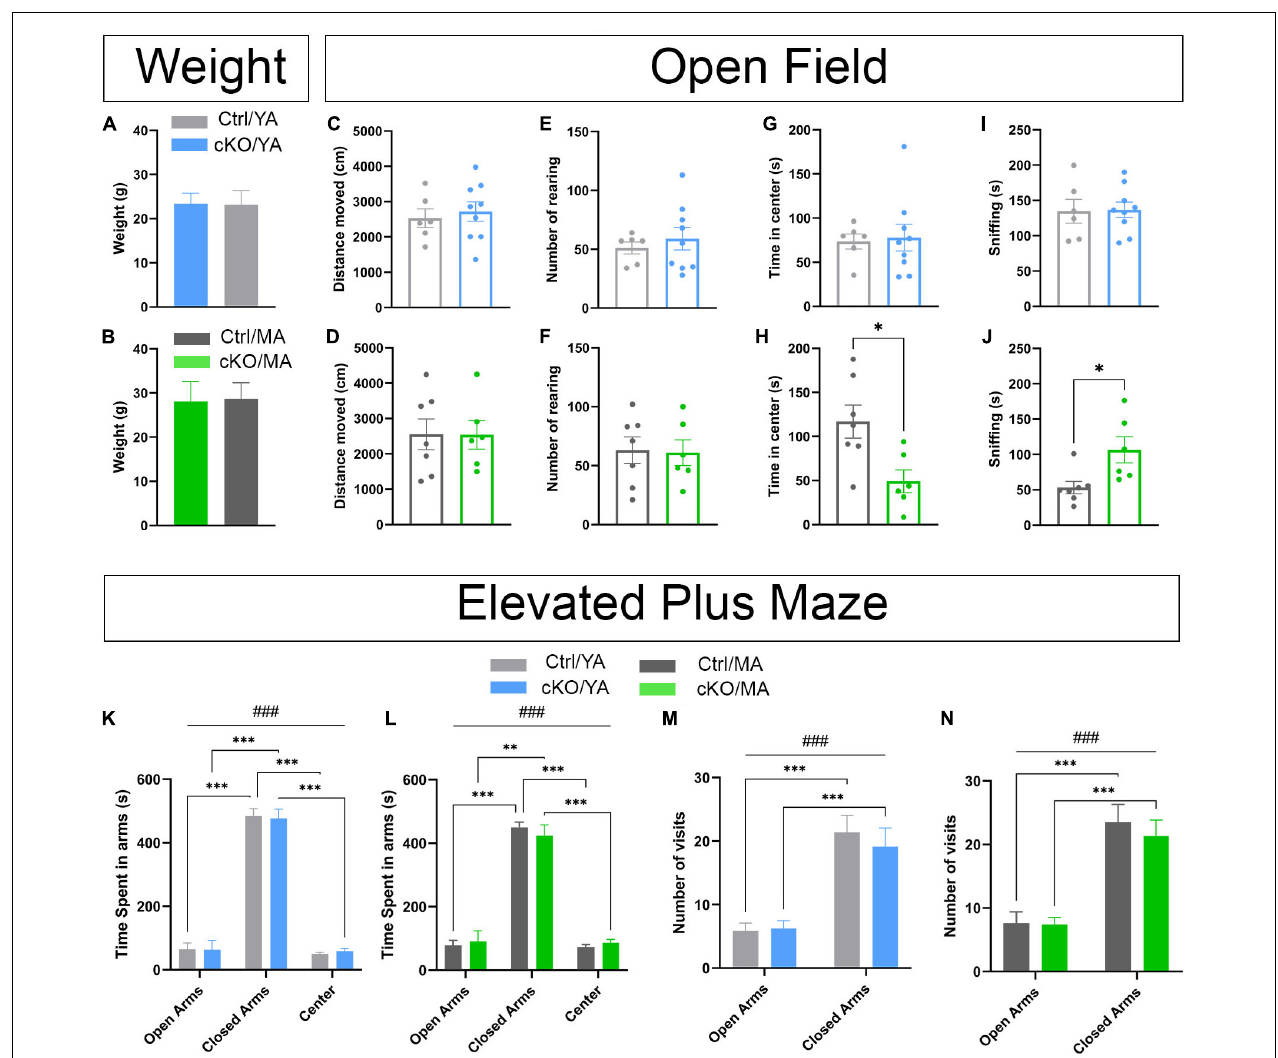
FIGURE 7 | No or modest genotype-dependent alterations in basal behavior were displayed by TrpV1 Cre + / wt ;Vmat2 flox / flox cKO mice. Analysis and comparison of age-matched TrpV1 Cre − / wt ;Vmat2 flox / flox control (Ctrl) and TrpV1 Cre + / wt ;Vmat2 flox / flox conditional knockout (cKO) mice at young adult (YA; 8 weeks old) and mature adult (MA; 18 weeks old) age. (A,B) Weight at the beginning of an amphetamine sensitization paradigm ( A , YA; B , MA). (C–J) An open field test. Ctrl/YA ( N = 6) and cKO/YA ( N = 9), Ctrl/MA ( N = 7), and cKO/MA ( N = 6) data are expressed as mean ± SEM. (C) distance-moved YA. (D) distance-moved MA. (E) Number of rearing YA. (F) Number of rearing MA. (G) Time spent in center YA. (H) Time spent in center MA (* p = .0154, Ctrl/MA vs. cKO/MA). (I) sniffing YA. (J) sniffing MA (* p = 0.0193, Ctrl/MA vs. cKO/MA). (K–N) Elevated plus maze (EPM). Ctrl/YA ( N = 8) and cKO/YA ( N = 13), Ctrl/MA ( N = 11) and cKO/MA ( N = 12), data are expressed as mean ± SEM. (K) time spent in arms YA (### p < 0.001, arms effect; *** p < 0.001, Closed Arms vs. Open Arms and Center). (L) Time spent in arms MA (### p < 0.001, arms effect; *** p < 0.001, Closed Arms vs. Open Arms and Center; ** p = 0.001, Closed Arms vs. Open Arms). (M) Number of visits in arms YA (### p < 0.001, arms effect; *** p < 0.001, Closed Arms vs. Open Arms). (N) Number of visits in arms MA (### p < 0.001, arms effect; *** p < 0.001, Closed Arms vs. Open